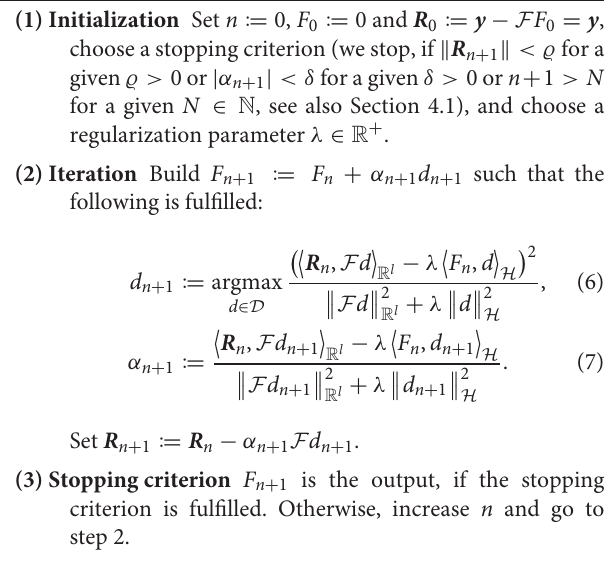
Algorithm 2.1 Let y and continuous) be